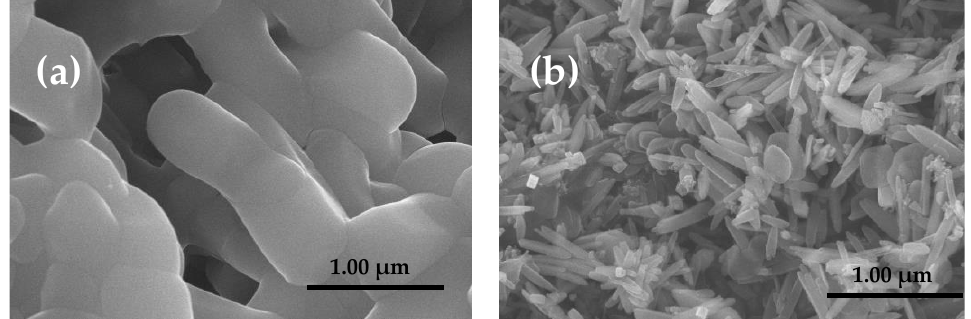
Figure 3. SEM graphs of FeF 3 ·3H 2 O ( a ) and FeOF ( b ).